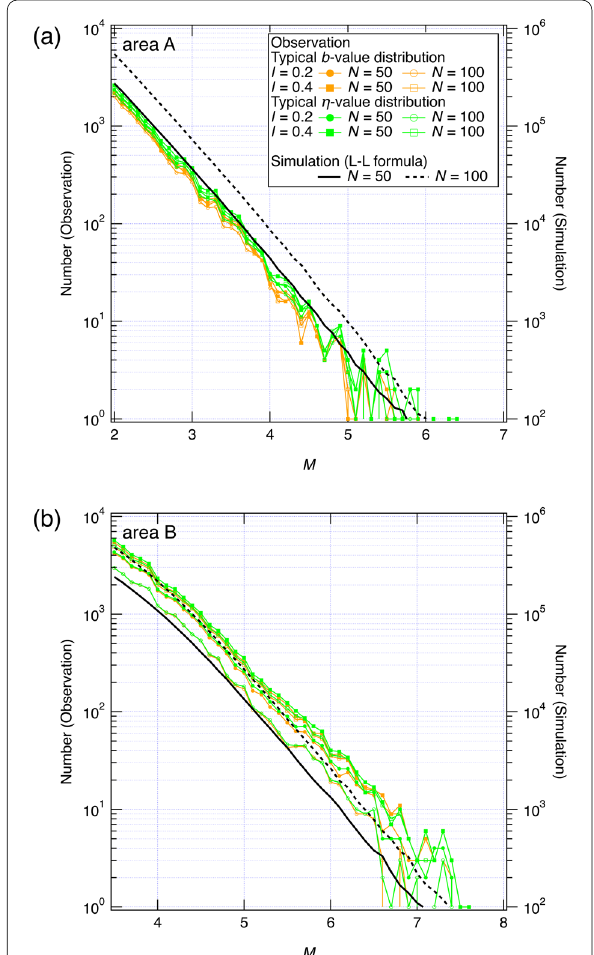
Fig. 19 Comparison of the observed FMDs with those expected from the L-L formula (Eq. 7) using the best-fit parameters. M data corresponding to the typical b -value and typical η -value PDDs are used for each N and l pair. a Area A; b area B